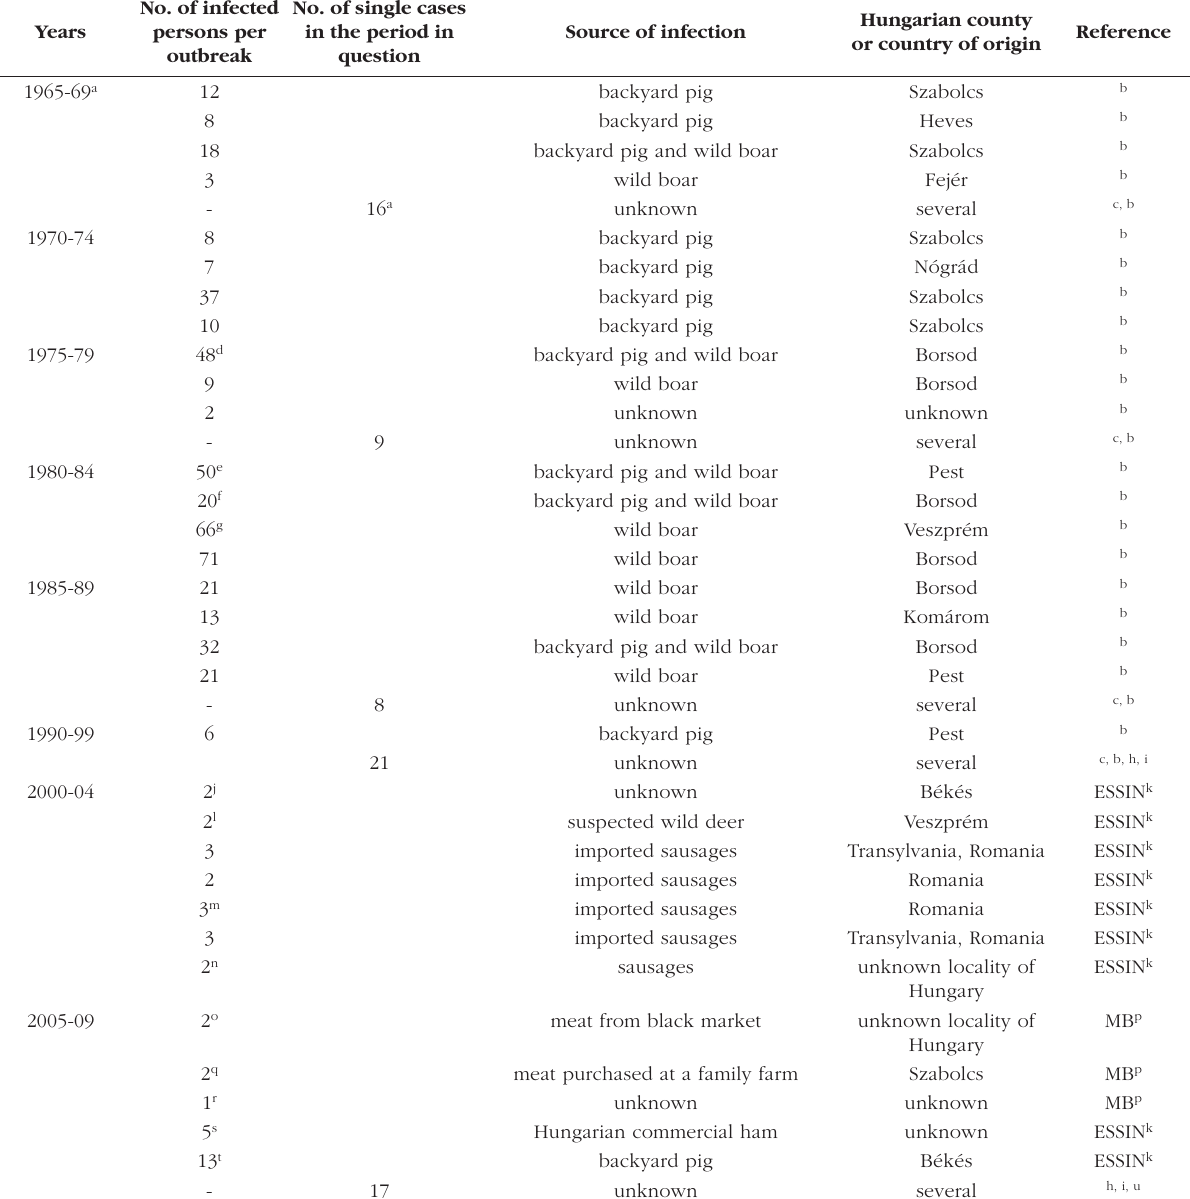
Table I. – Epidemiological data on human trichinellosis which occurred in Hungary from 1965 to